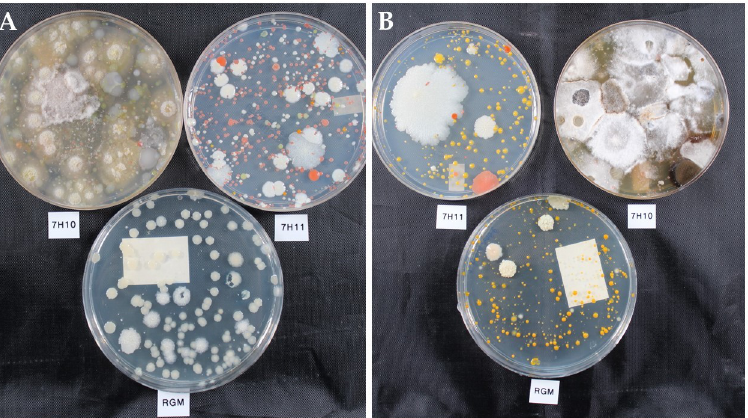
Fig 1. Visual comparison of two environmental water samples plated on 7H10 and 7H11 after acid treatment and RGM medium directly after six weeks of incubation. The 7H10 and 7H11 plates grew many and varied microbial species, however RGM medium selected for only NTM A) white, beige colonies and B) white, beige and yellow-orange